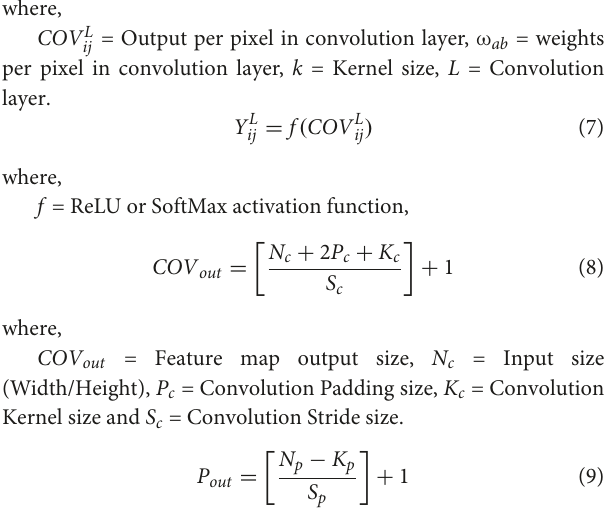
where, COV out = Feature map output size, N c = Input size (Width/Height), P c = Convolution Padding size, K c =